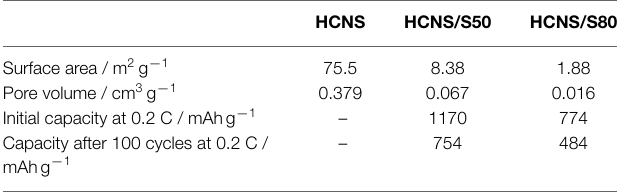
TABLE 1 | BET results and electrochemical performance of HCNS/S composites